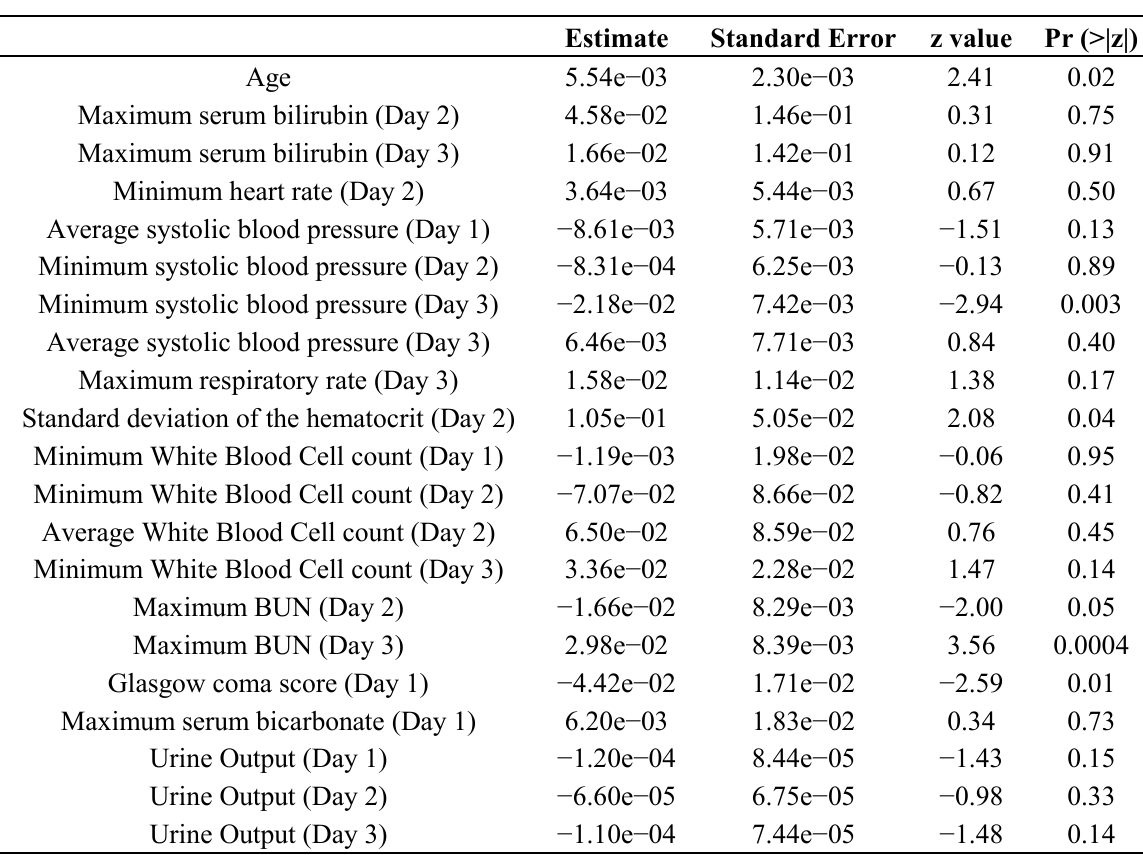
Table 2. Best fitted logistic regression model for ICU patients who developed